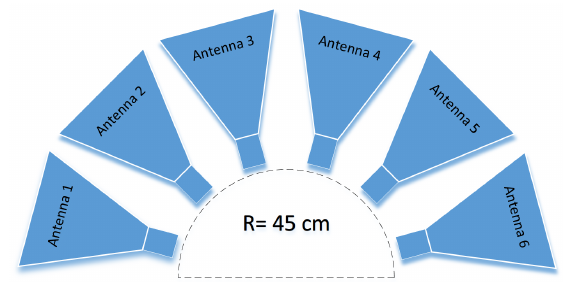
Figure 3. Radar antennas array.